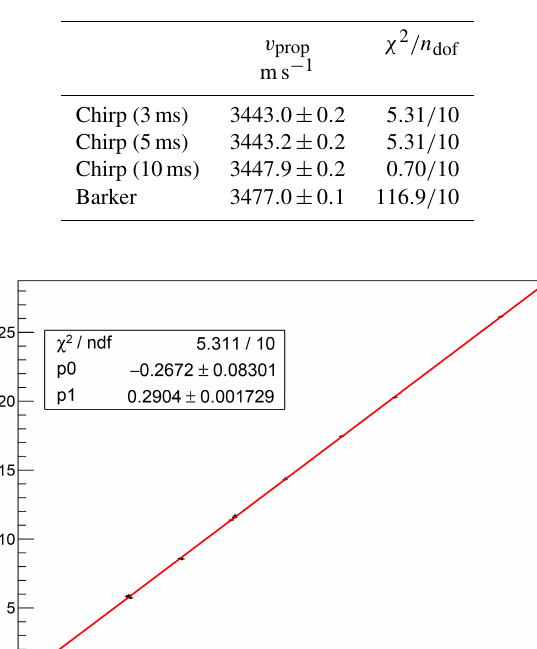
signal with a variable time offset. The time offset of maxi- mum correlation determines the signal propagation time. The median from all repetitions of the same measurement is taken as well as the difference of the 15.85 % and 84.15 % quantiles for an estimate of the